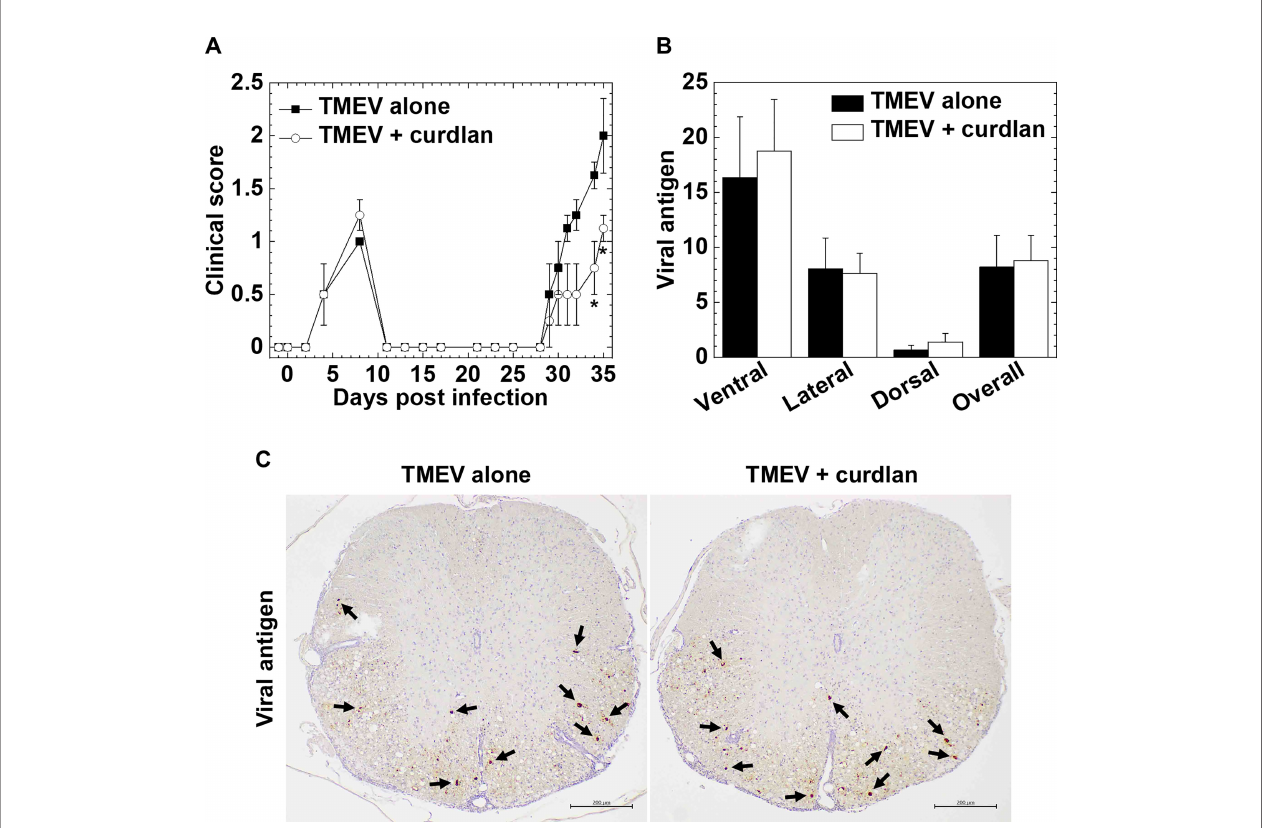
FIGURE 3 | Curdlan treatment suppressed chronic Theiler ’ s murine encephalomyelitis virus (TMEV)-induced demyelinating disease (TMEV-IDD). (A) We evaluated the clinical signs by impaired righting re fl ex scores in the control mice (closed boxes) and curdlan-treated mice (open circles) following TMEV infection. One day prior to TMEV infection, mice were injected with curdlan (TMEV + curdlan); the control mice had no treatment (TMEV alone). The curdlan treatment group had a delayed disease onset and less severe clinical signs during the chronic phase, 1 month post infection (p.i.), but not during the acute phase, 1 week, p.i. Results are representative of three independent experiments (four mice per group per experiment). * P < 0.05, Mann-Whitney U test. (B) Numbers of viral antigen-positive cells of the spinal cord tissue sections from the control mice (black bar) and curdlan-treated mice (white bar) 5 weeks after TMEV infection. Values are the mean + SEM of four mice per group. (C) Immunohistochemistry against viral antigens of the spinal cord tissue sections from the control mice and curdlan-treated mice 5 weeks after TMEV infection. Arrows indicate viral antigen-positive cells (scale bar = 200 m m). Tissue sections were representative of four mice per